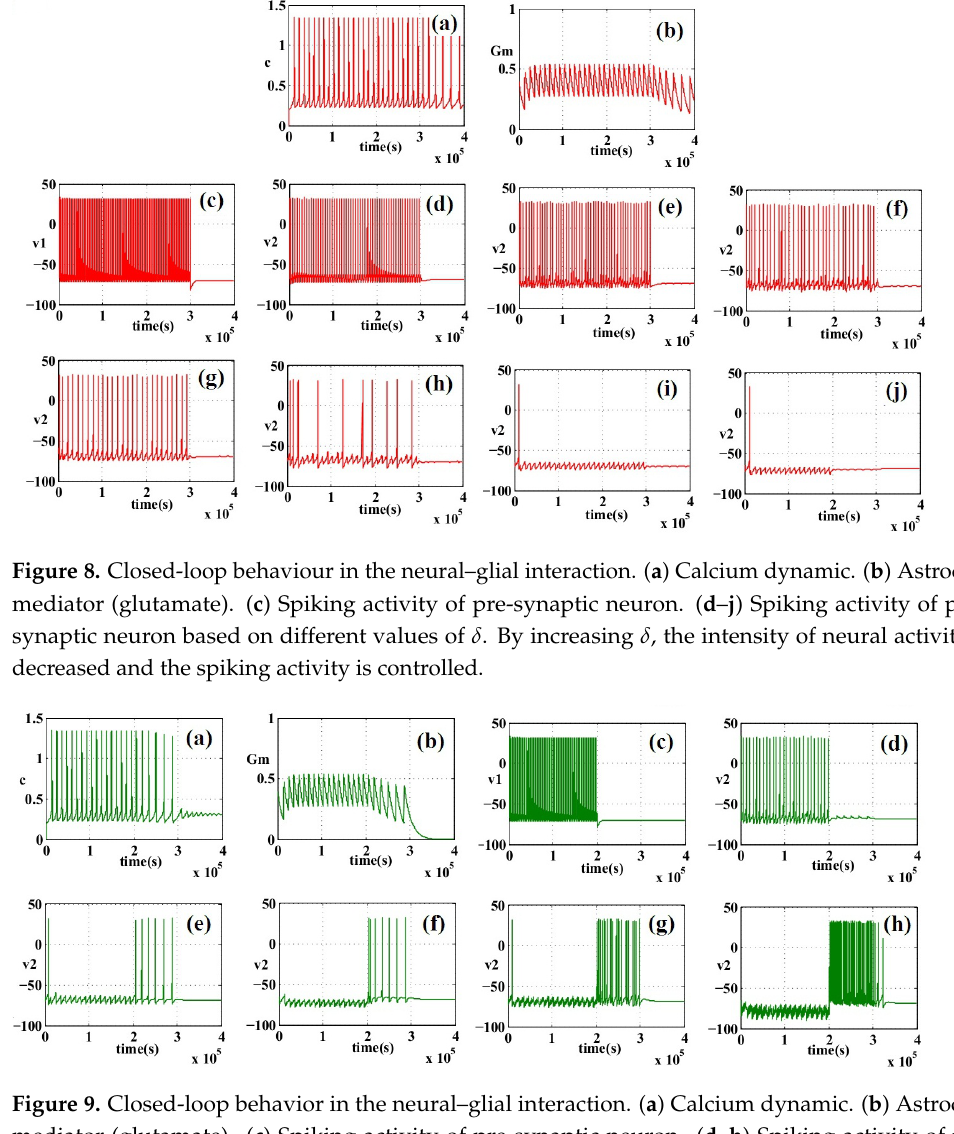
Figure 9. Closed-loop behavior in the neural–glial interaction. ( a ) Calcium dynamic. ( b ) Astrocyte mediator (glutamate). ( c ) Spiking activity of pre-synaptic neuron. ( d – h ) Spiking activity of pos- tsynaptic neuron based on different values of γ , δ . By increasing δ and decreasing γ , the spiking activity of post-synaptic neuron is regulated. In this case, when the pre-synaptic neuron is already in the resting state, the post-synaptic neuron starts to activate